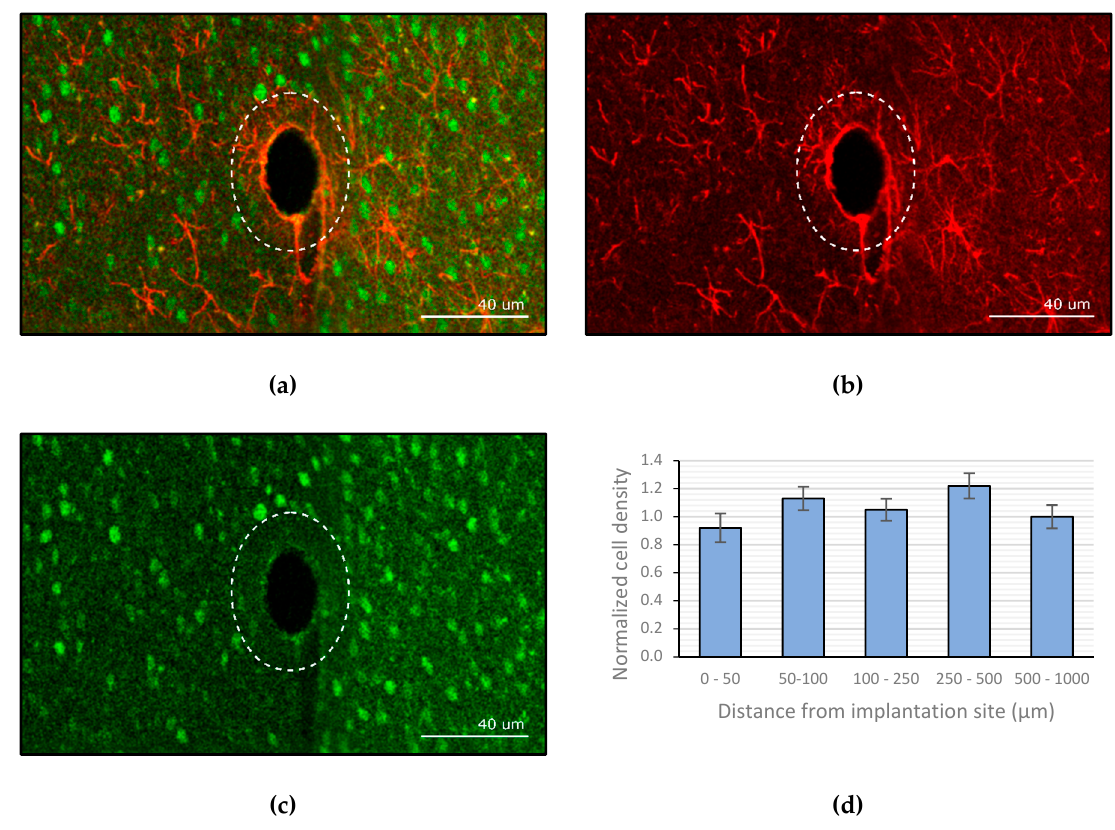
Figure 7. Confocal imaging of the brain slices ( a ) overlay of both the glial fibrillary acidic protein (GFAP) and neuronal nuclei (NeuN) stained channels. ( b ) GFAP channel. ( c ) NeuN channel. ( d ) Normalized neuronal density relative to site of implantation (the error bars represent the standard deviation, n = 6).